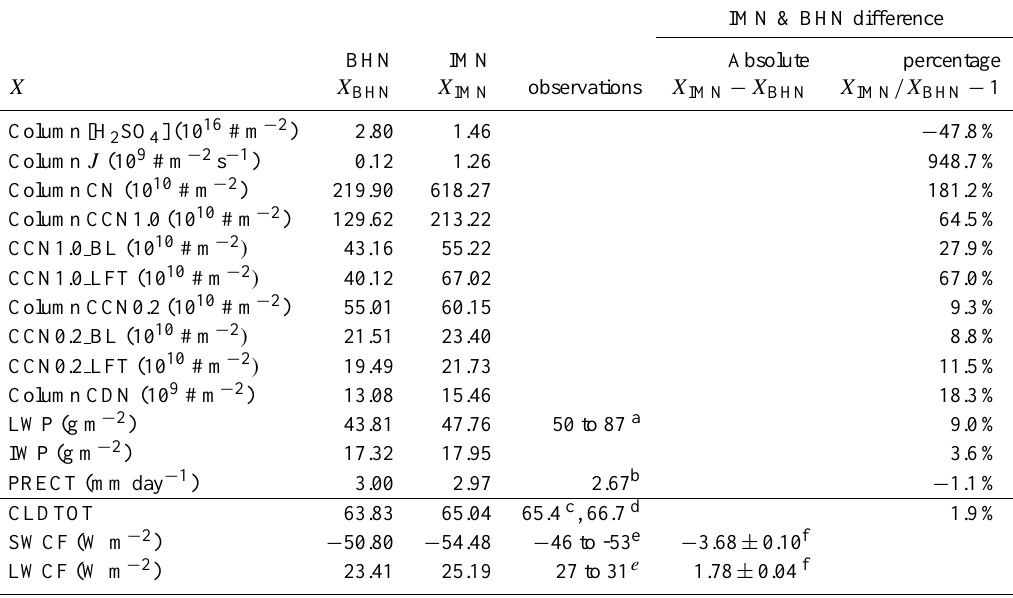
Table 1. Globally averaged sulfuric acid vapor concentration ([H 2 SO 4 ]), nucleation rate ( J ), concentrations of condensation nuclei (CN) and cloud CN at water supersaturation ratio of 1.0% and 0.2% (CCN1.0, CCN0.2), cloud droplet number concentration (CDN), liquid water path (LWP), ice water path (IWP), precipitation (PRECT), total cloud cover (CLDTOT), shortwave cloud forcing (SWCF), and longwave cloud forcing (LWCF) for both BHN and IMN cases, as well as the differences for the two cases showing the impacts of ionization. To account